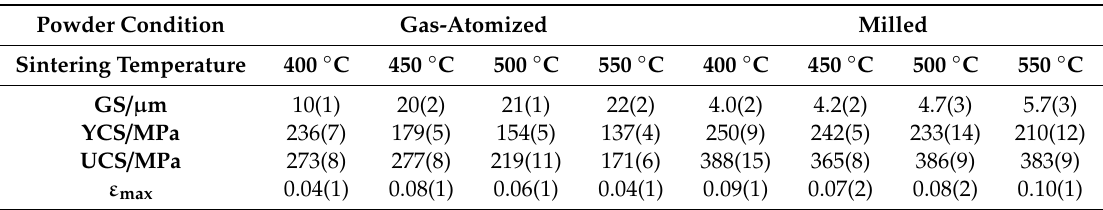
Table 1. Yield compression strength (YCS), ultimate compression strength (UCS), and strain corresponding to UCS ( ε max ) calculated for all investigated